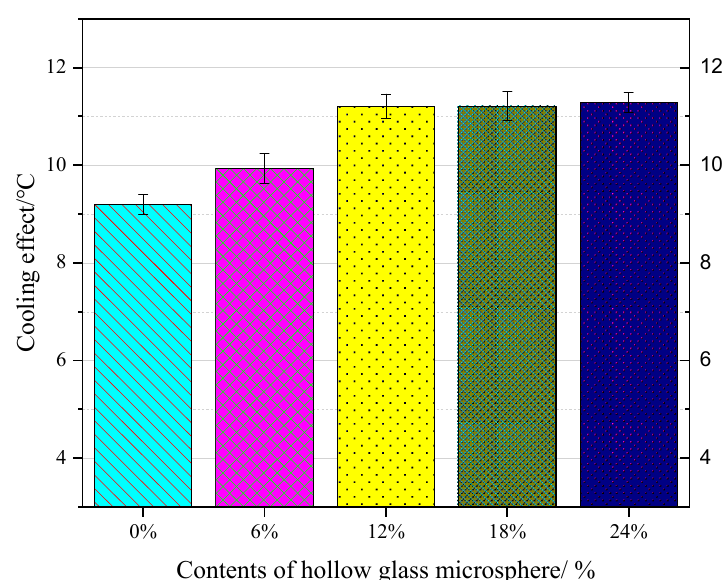
Figure 12. The cooling effect for samples with different contents of hollow glass microspheres.